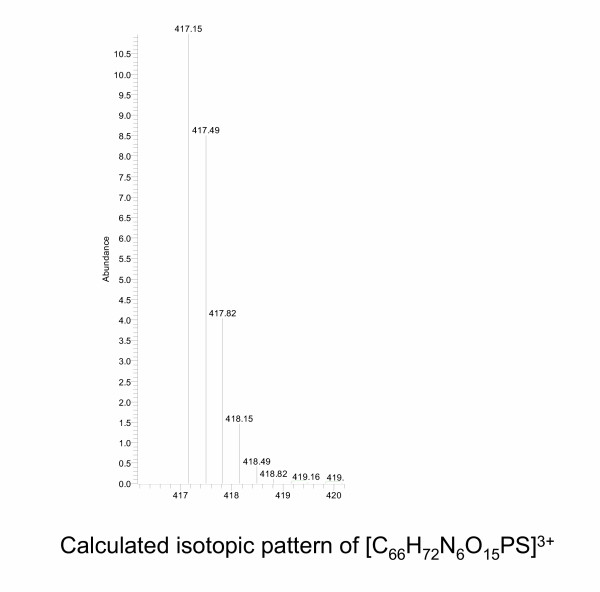
Calculated isotopic pattern of [C66H72N6O15PS]3+.